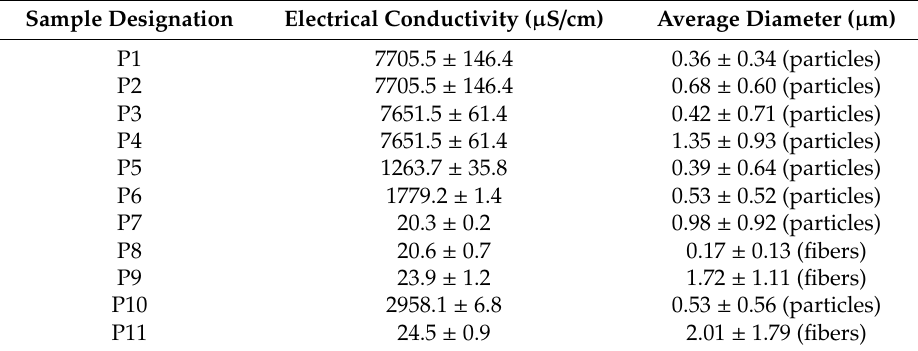
Table 1. Electrical conductivity of the potato protein solutions and the average diameter of the particles and fibers produced by